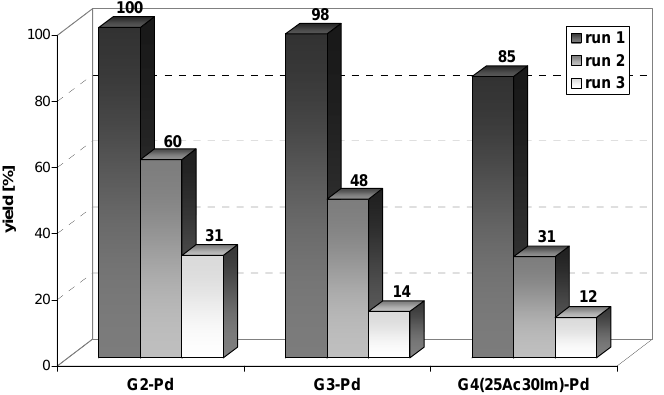
Figure 9. Results of recycling of G2-Pd, G3-Pd and G4 25Ac30Im –Pd in Suzuki-Miyaura